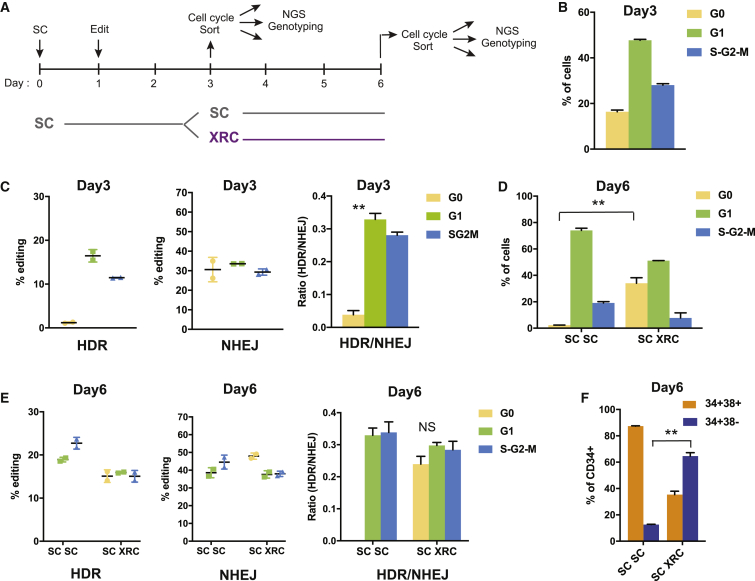
Inducing Quiescence after a Short Period of Cycling Yields Quiescent, Primitive HSPCs That Harbor HDR Alleles(A) Schematic of the workflow for inducing quiescence after a short period of cycling. CD34+ HSPCs are placed in SC culture for 1 day before editing and cycle for 2 additional days in SC culture, and then quiescence is induced with XRC for 3 days before the cells are subjected to FACS based on their cell cycle status and genotyped by NGS.(B) Cell cycle profiles of CD34+ cells 3 days in culture (SC). Most CD34+ HSPCs are cycling at day 3. Representative data from experiments performed with three different mPB donors and n = 2 biological replicates per donor. Mean ± SD shown.(C) Editing outcomes in CD34+ cells 3 days in culture (SC). HDR repair does not take place in G0 CD34+ HSPCs. Representative data from experiments performed with three different mPB donors and n = 2 biological replicates per donor. Mean ± SD shown. ∗∗p < 0.01 by unpaired t test.(D) Cell cycle profiles of CD34+ cells 6 days in culture (3 days in SC media and 3 additional days in SC media or XRC). Three days in XRC induces quiescence in 30% of the cells. Representative data from experiments performed with three different mPB donors and n = 2 biological replicates per donor. Mean ± SD shown. ∗∗p < 0.01 by unpaired t test.(E) Editing outcomes in CD34+ cells 6 days in culture (3 days in SC media and 3 additional days in SC media or XRC). Three days in XRC results in HDR edits in G0 CD34+ HSPCs. Representative data from experiments performed with three different mPB donors and n = 2 biological replicates per donor. Mean ± SD shown.(F) Percentage of CD34+ cells that are CD34+CD38+ (progenitors) versus CD34+CD38− (EE HSPCs) 6 days in culture. CD34+ cells that regained quiescence in XRC include a higher proportion of EE HSPCs than CD34+ cells maintained solely in SC media. Representative data from experiments performed with three different mPB donors and n = 2 biological replicates per donor. Mean ± SD shown. ∗∗p < 0.01 by unpaired t test.See also Figure S4.